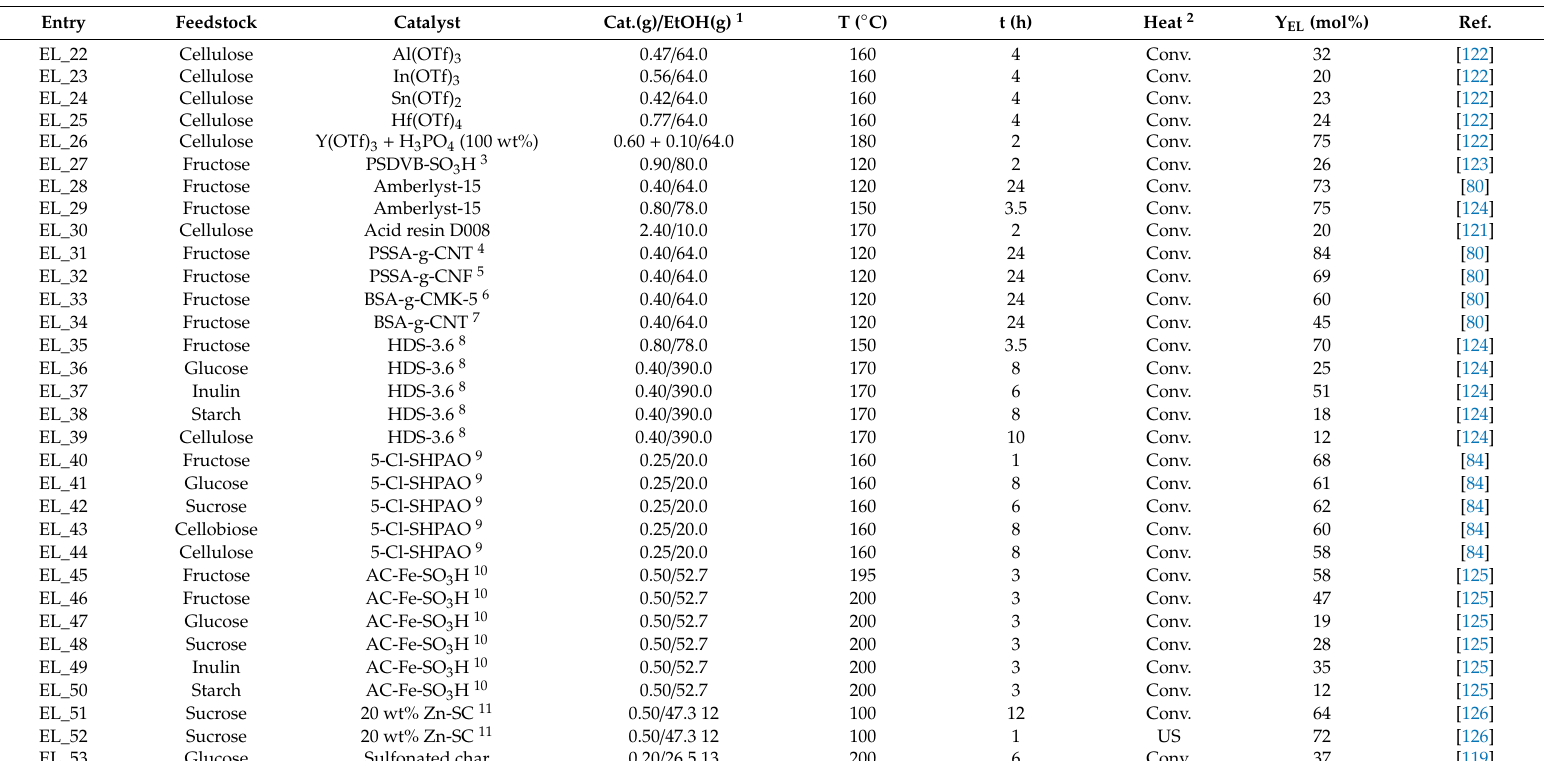
Table 8. Sulfonic acids, sulfonate salts, and their combinations for the EL production from C6 model